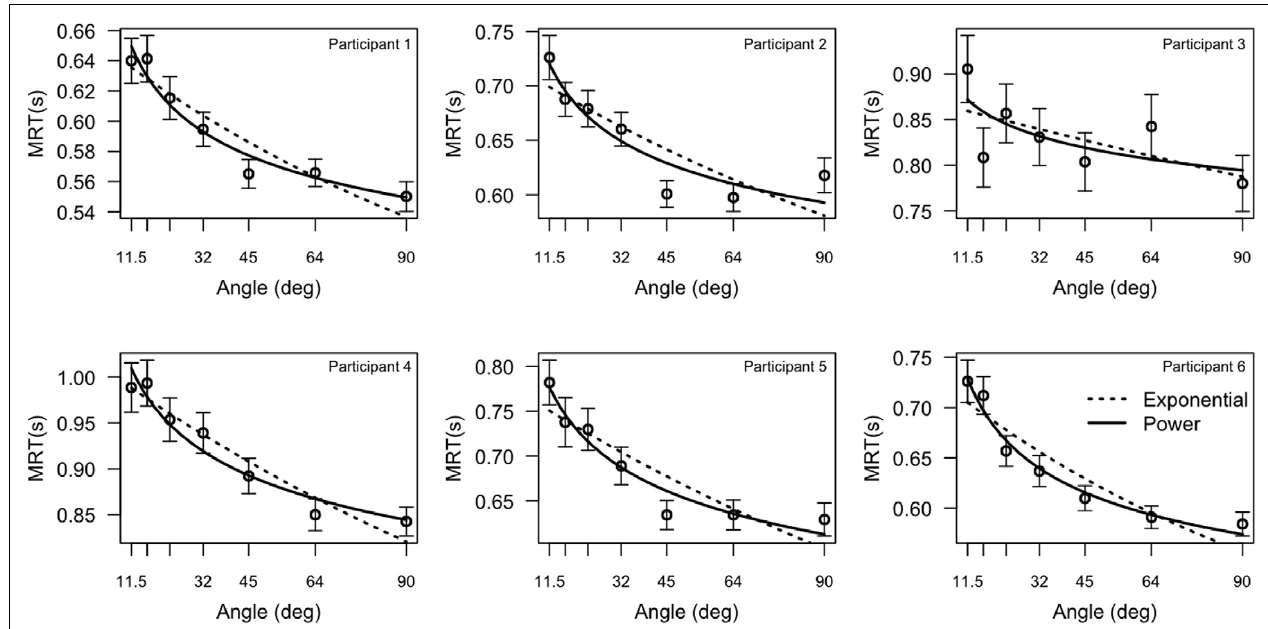
FIGURE 3 | Mean response times (MRT) as a function of angular distance. Each plot represents the data from one participant. (Error bars represent within-subjects standard error of the mean, Loftus and Masson, 1994).The best fitting power function and the best fitting exponential function are overlaid.